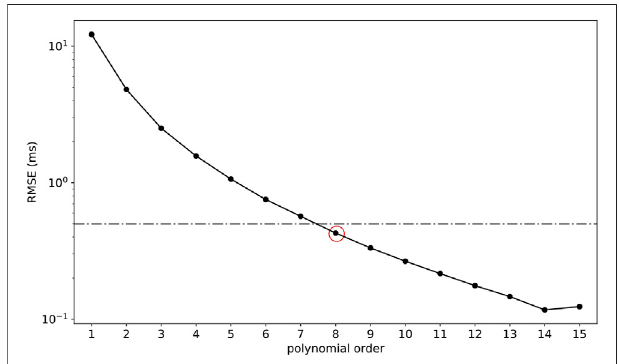
FIGURE 3 | Boundary relationship between t ce and t fe . A linear regression (solid line) was obtained using 85% of the entire boundary points (training set, small gray dots) and validated on the remaining 15% points (testing set, large black dots). Predictions are given by the black circles and led to a root-mean-square error of 3.2 ms ( R 2 (cid:2) 99 . 9% ) .